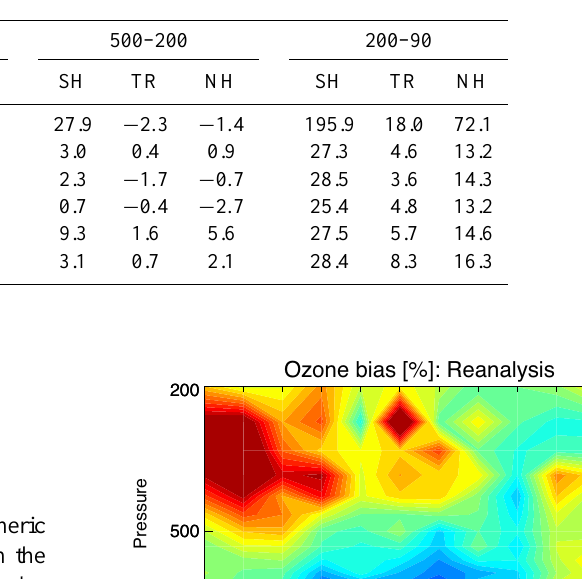
Table 6. Model-minus-observation comparison of mean O 3 concentrations (in ppb) between the control/reanalysis calculations and the ozonesonde observations for 2005 in the SH (90–30 ◦ S), TR (30 ◦ S–30 ◦ N), and NH (30–90 ◦ N). Sensitivity reanalysis calculations were conducted by excluding the emission factors from the state vector (w/o emission), with TES O 3 bias correction (TES-bias), without assimi- lation of TES measurements (w/o TES), and with HTAP-v2 emission inventories for 2008 as the a priori surface emissions (HTAP).